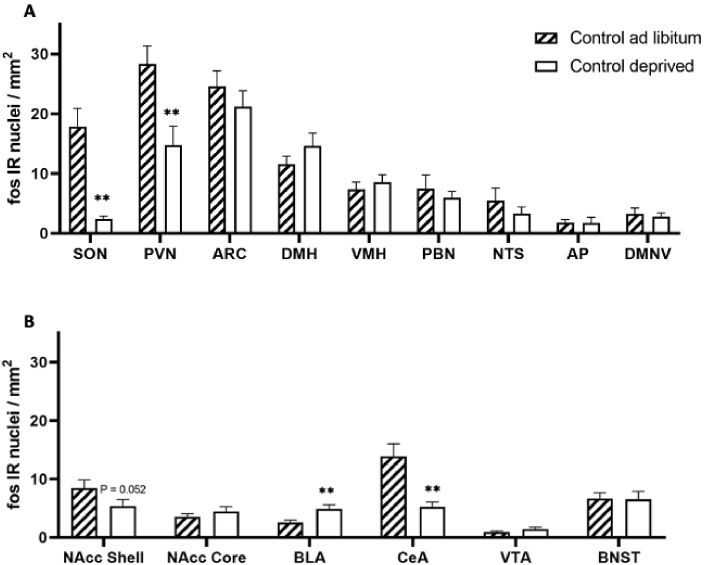
Figure 5. c-Fos immunoreactivity in ad libitum-fed and food-deprived healthy control animals.